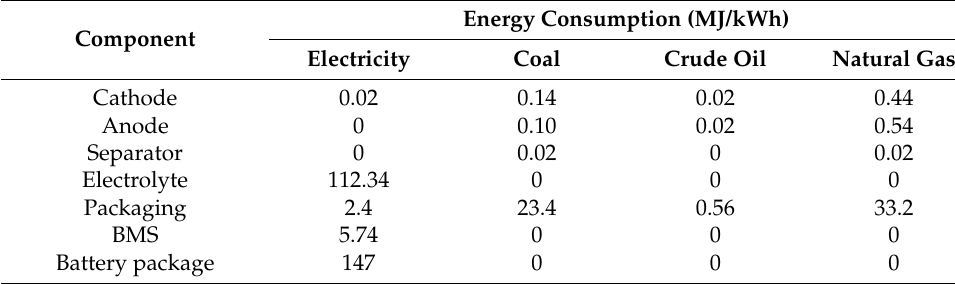
Table A5. Energy consumption inventory of the